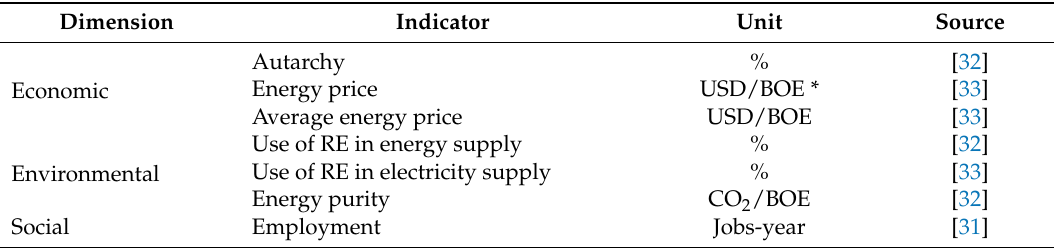
Table 2. The sustainability energy indicators.